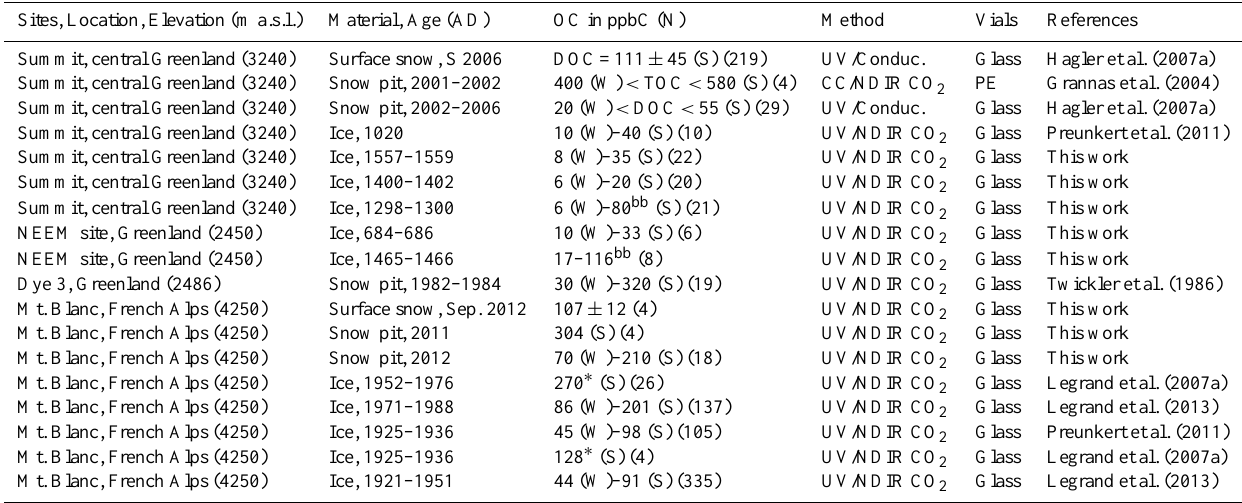
∗ Sampling year not specified. ∗∗ Numerous samples were contaminated following difficulties in properly closing the cap of glass bottle at cold temperatures (see details in Sect. 2.3.1). Table 2. Same as Table 1 but for OC content of snow and ice from various Greenland sites and the Alps. Values are reported as DOC when samples that were measured with a UV oxidation method were previously filtered to remove particulate organic material (see Sect. 3.2.1). All other values that were obtained with a UV oxidation method without filtration of samples would correspond to TOC and DOC in the case of snow and ice from Greenland and the Alps, respectively (see Sect. 3.2.1). Sites, Location, Elevation (m